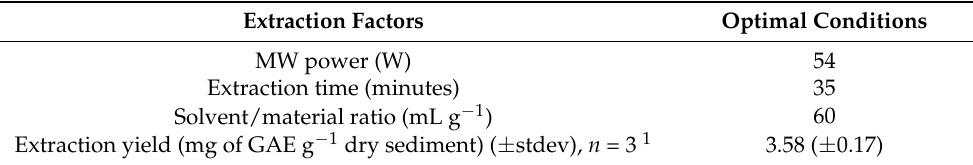
Table 2. Optimal MAE conditions. Extraction